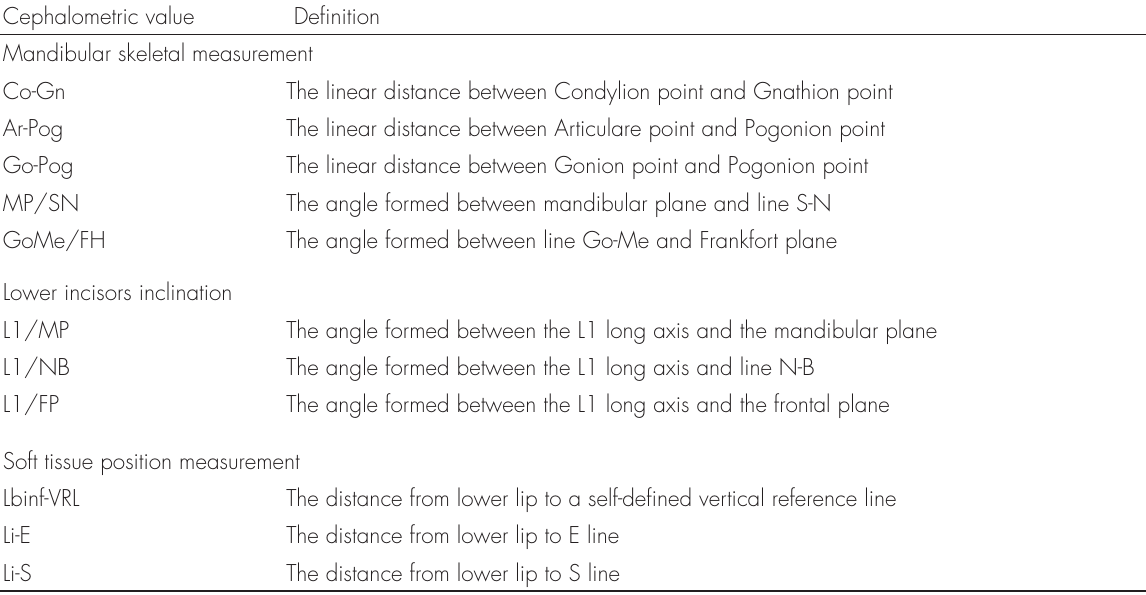
Table V. Definition of cephalometric